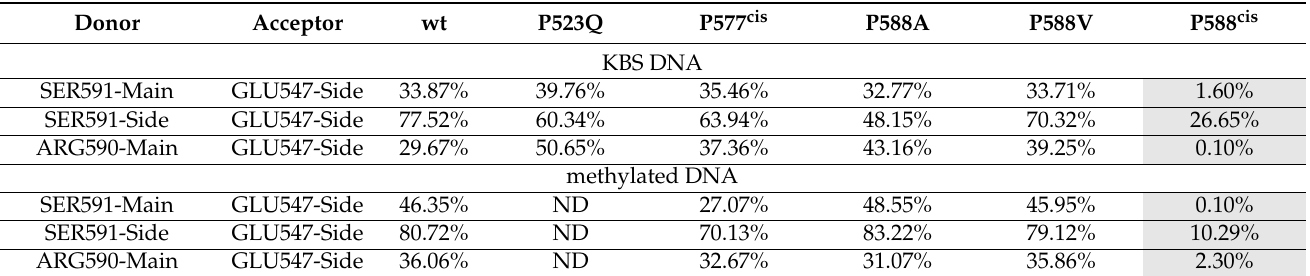
Table 1. The presence of the E547-R590/S591 hydrogen bond along last 90 ns of 100 ns molecular dynamics trajectories of Kaiso complexes with Kaiso binding sequence and methylated DNA. Grey fill indicates H-bonds weakened 5 × times or more compared to wild-type